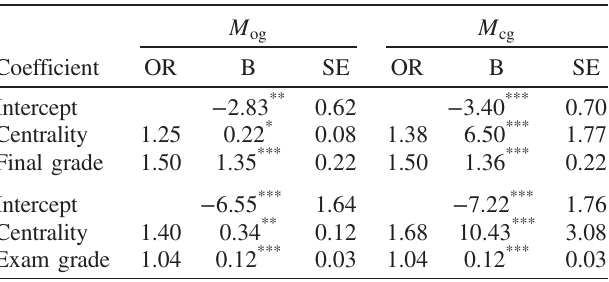
TABLE VIII. Model verification with grade. Odds ratio (OR), estimates (B), and standard error (SE) for simple logistic regression models for persistence as predicted by out-of-class outdegree and grade ( M ; columns 2 – 4) and out- og of-class closeness and grade ( M ; columns 5 – 7). We consider cg two test cases for the grade variable: (1) final grades ( N ¼ 239 ); (2) midterm scores ( N ¼ 144 ). The odds ratio for grade is rescaled to reflect the increase by a partial letter grade (i.e., from B to Bþ). Significant P values are marked with an asterisk.